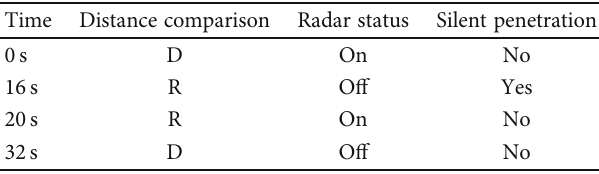
Figure 14: Simulation results of radar detection range. (a) Radar detection range model of looking up. (b) Radar detection range model of looking down at the altitude of 1000 m, 3000m, and 10000 m, respectively. The circle represents the radar detection range in km. Table 5: Extraction results of silent penetration